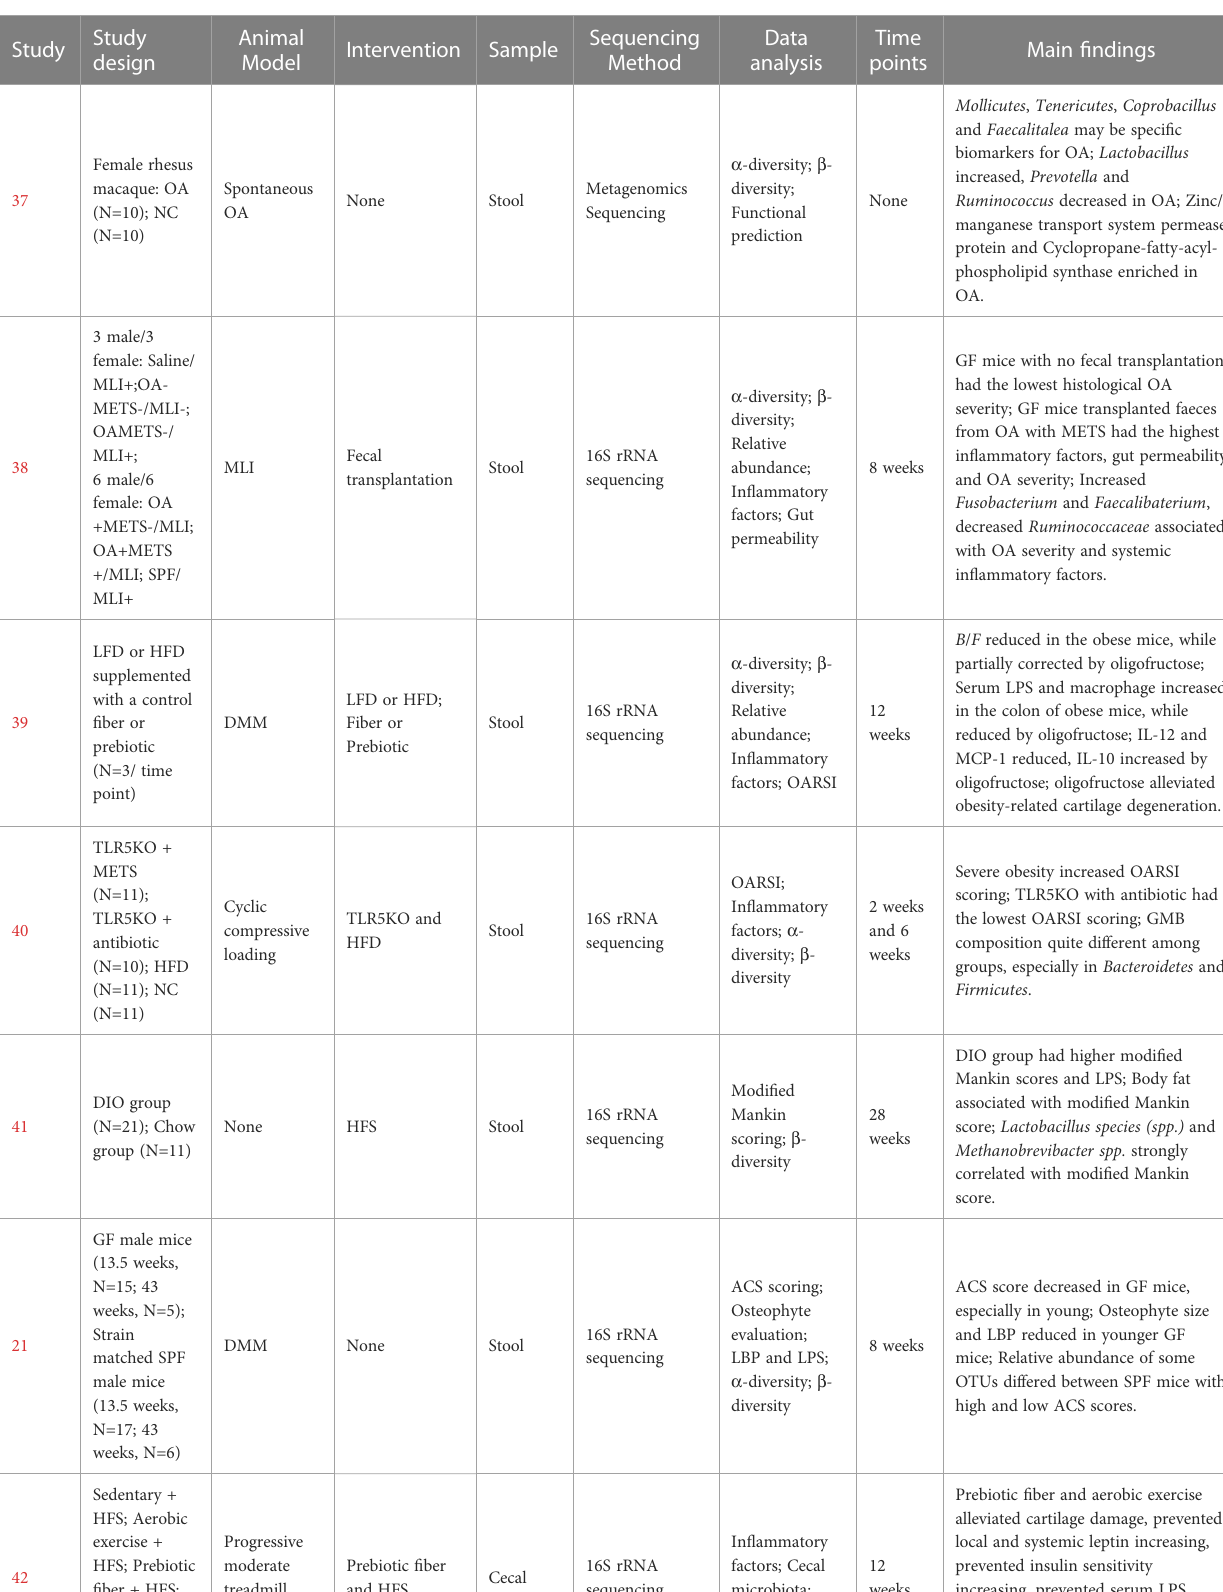
TABLE 2 Animal Experiments on GMB and